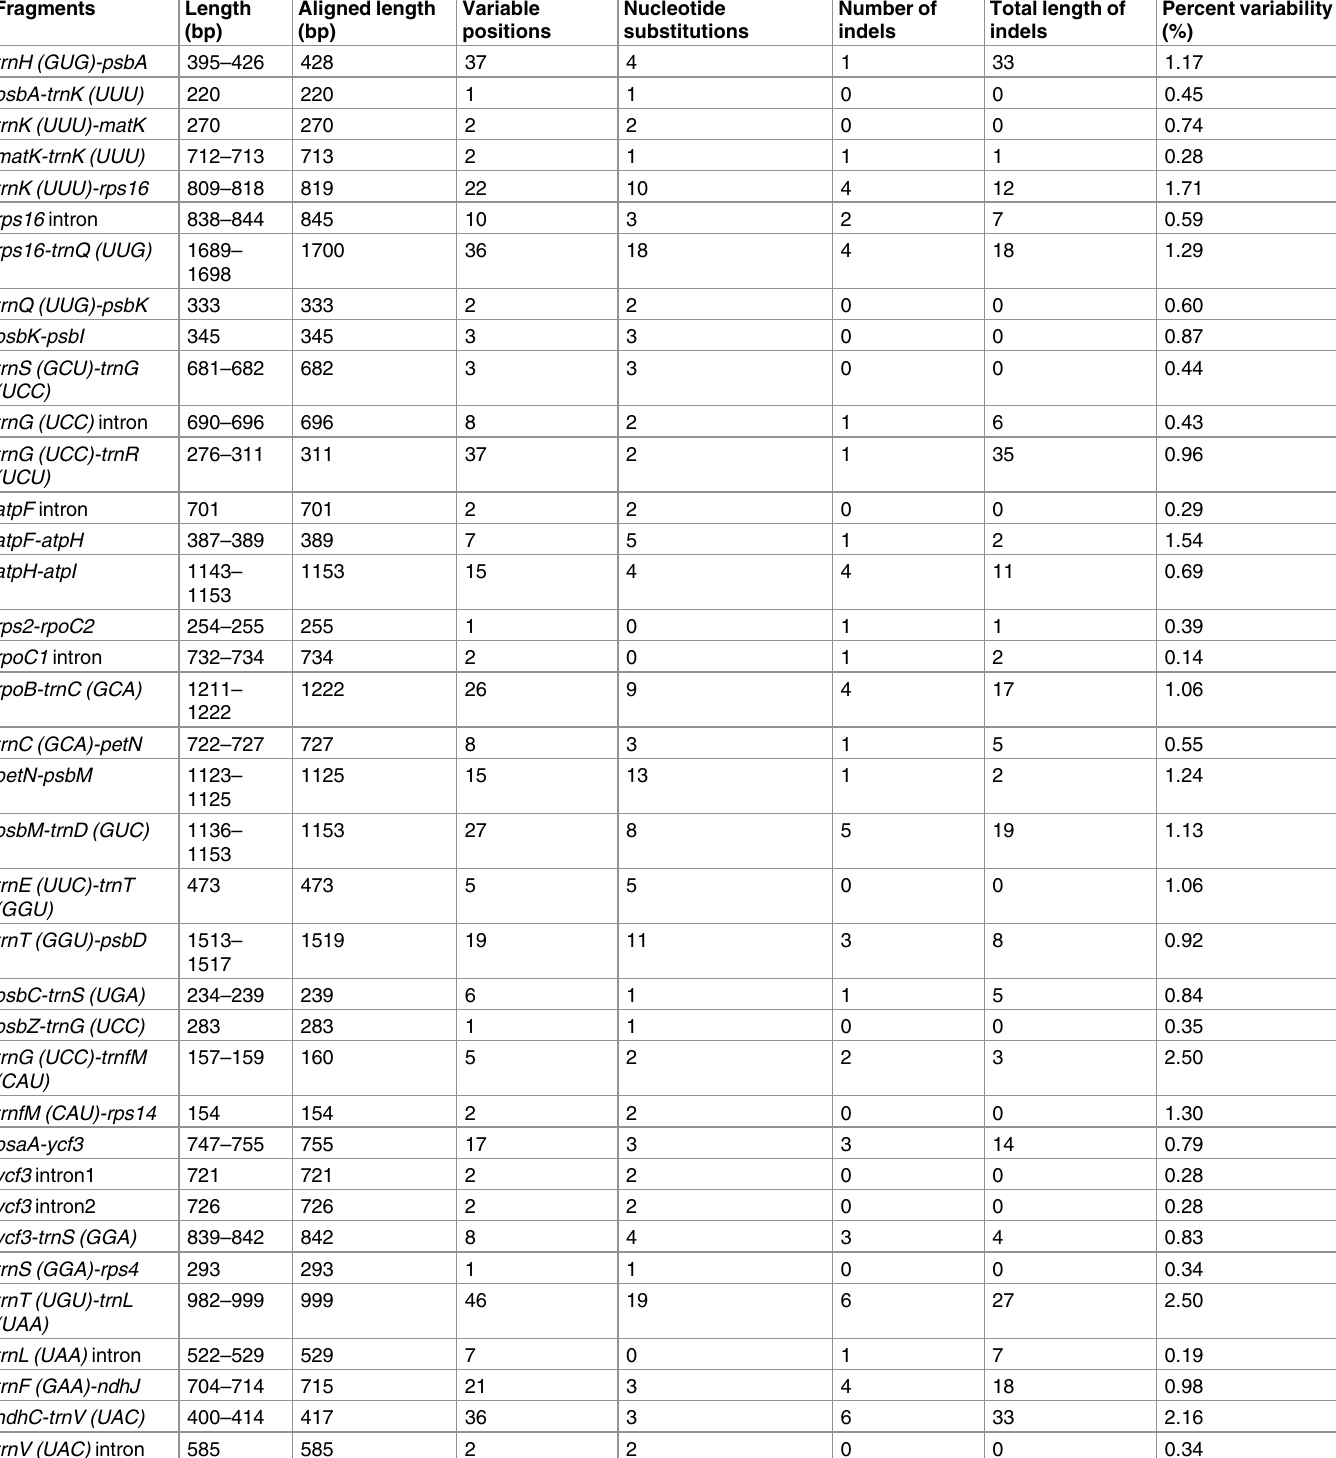
Table 3. Sequence divergence of 79 variable noncoding loci ( > 150bp) from 11 chloroplast genomes of Schima , with one of the invert repeat regions